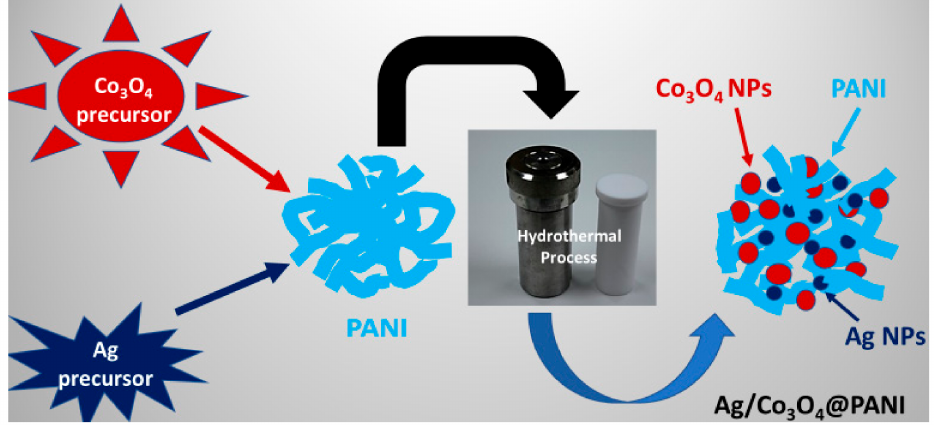
Figure 1. Schematic illustration of the synthesis of Ag / Co 3 O 4 @PANI ternary nanocomposite by the hydrothermal